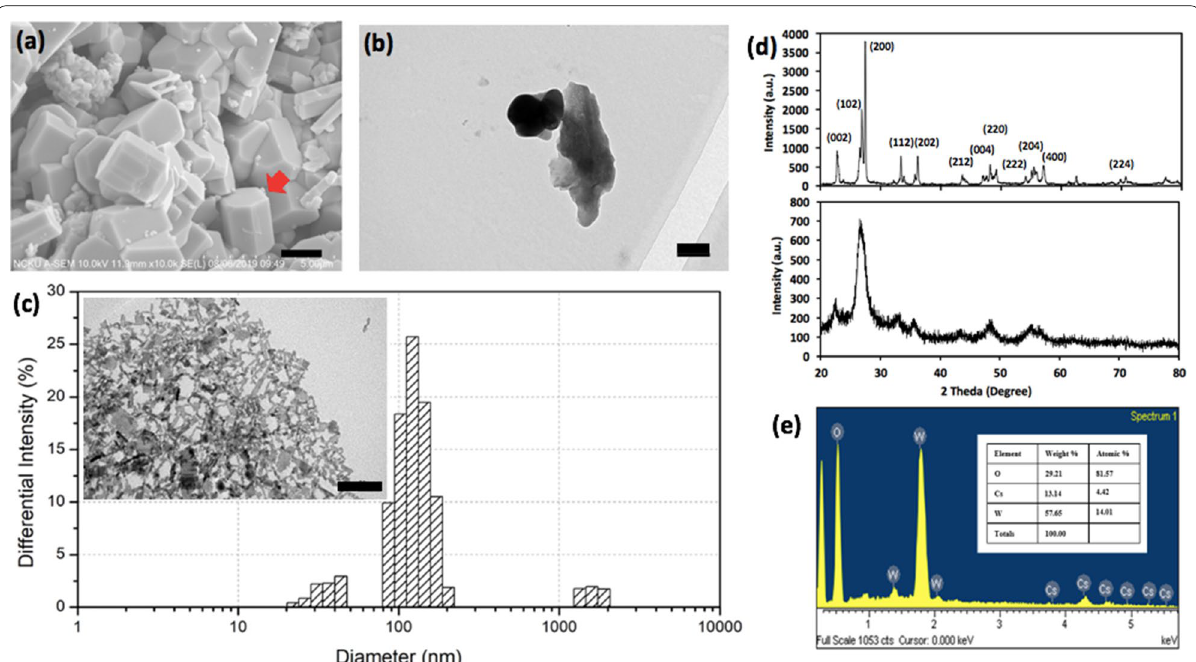
Fig. 2 Physical and material characterization. a SEM and b TEM images of the µpowder, c DLS distribution histogram of NP feature size, d XRD spectra of µpowder and 120 nm NPs, and e EDS spectrum with percentage of atomic composition are presented. The scale bars in a , b , c are 1.5 μm, 200 nm and 100 nm,